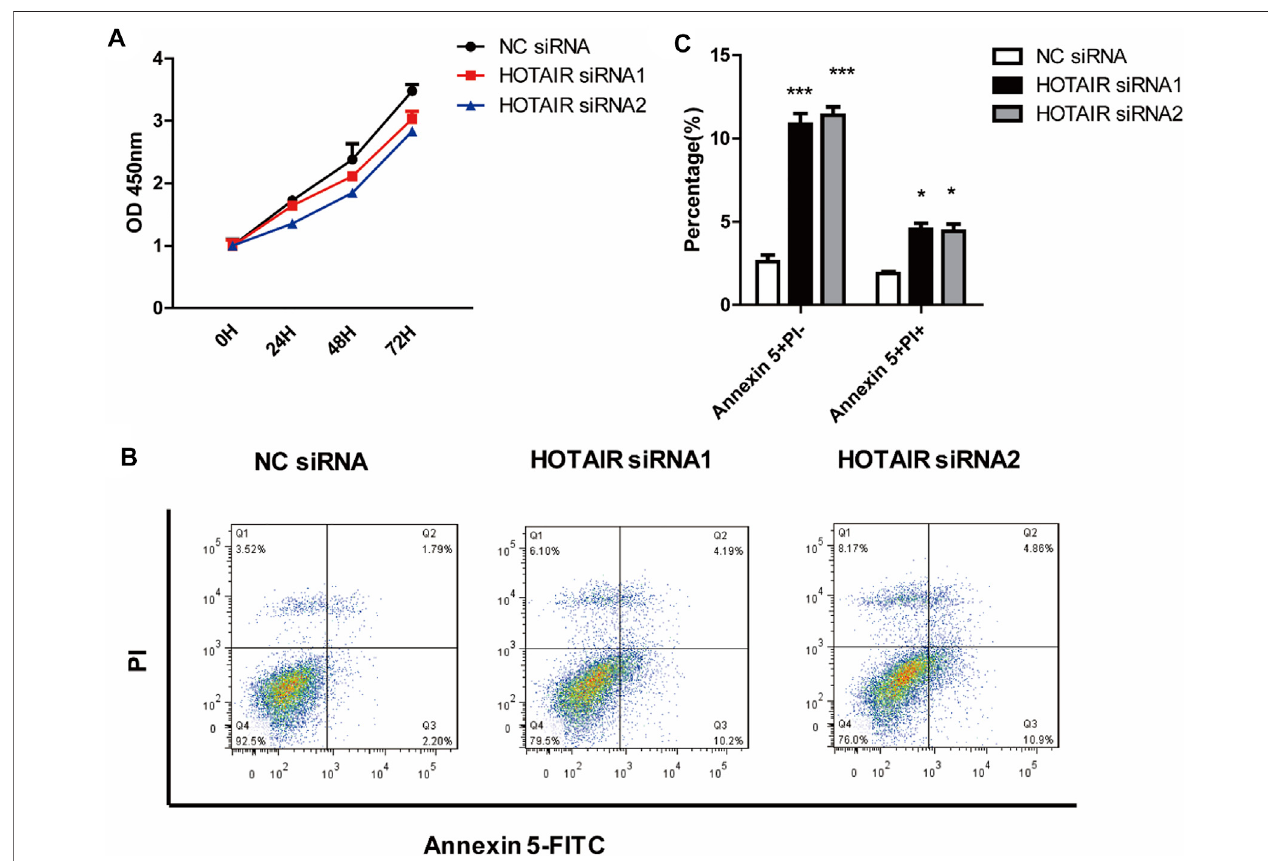
FIGURE2| HOTAIRsuppressestheapoptosisofmatureosteoclasts (A) RAW264.7cellswereculturedwithM-CSFintheabsenceorpresenceofHOTAIRsiRNA for 3 days. Then, the proliferation ability of early osteoclast precursors was analyzed by CCK-8 assay (B) After transfection with HOTAIR siRNA or the corresponding NCs,RAW264.7cellsweretreatedwithRANKLandM-CSFfor5 daysandstainedwithAnnexin5-FITCandpropidiumiodide(PI).Cellswerethenanalyzedusinga fl ow cytometer. Early apoptotic cells were Annexin5 + and PI − and late apoptotic cells were Annexin5 + and PI + (C) Quanti fi cation of apoptosis cells was analyzed. Bars represent the mean ± SEM. * p < 0.05, *** p < 0.001. The data are representative of three independent